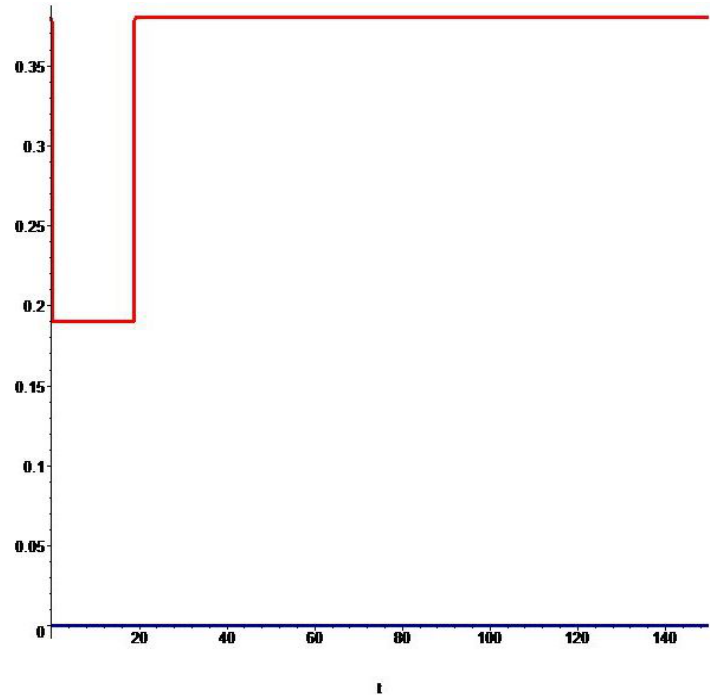
( t ) , v ( t ) for the Ebola outbreak in ∗ ∗